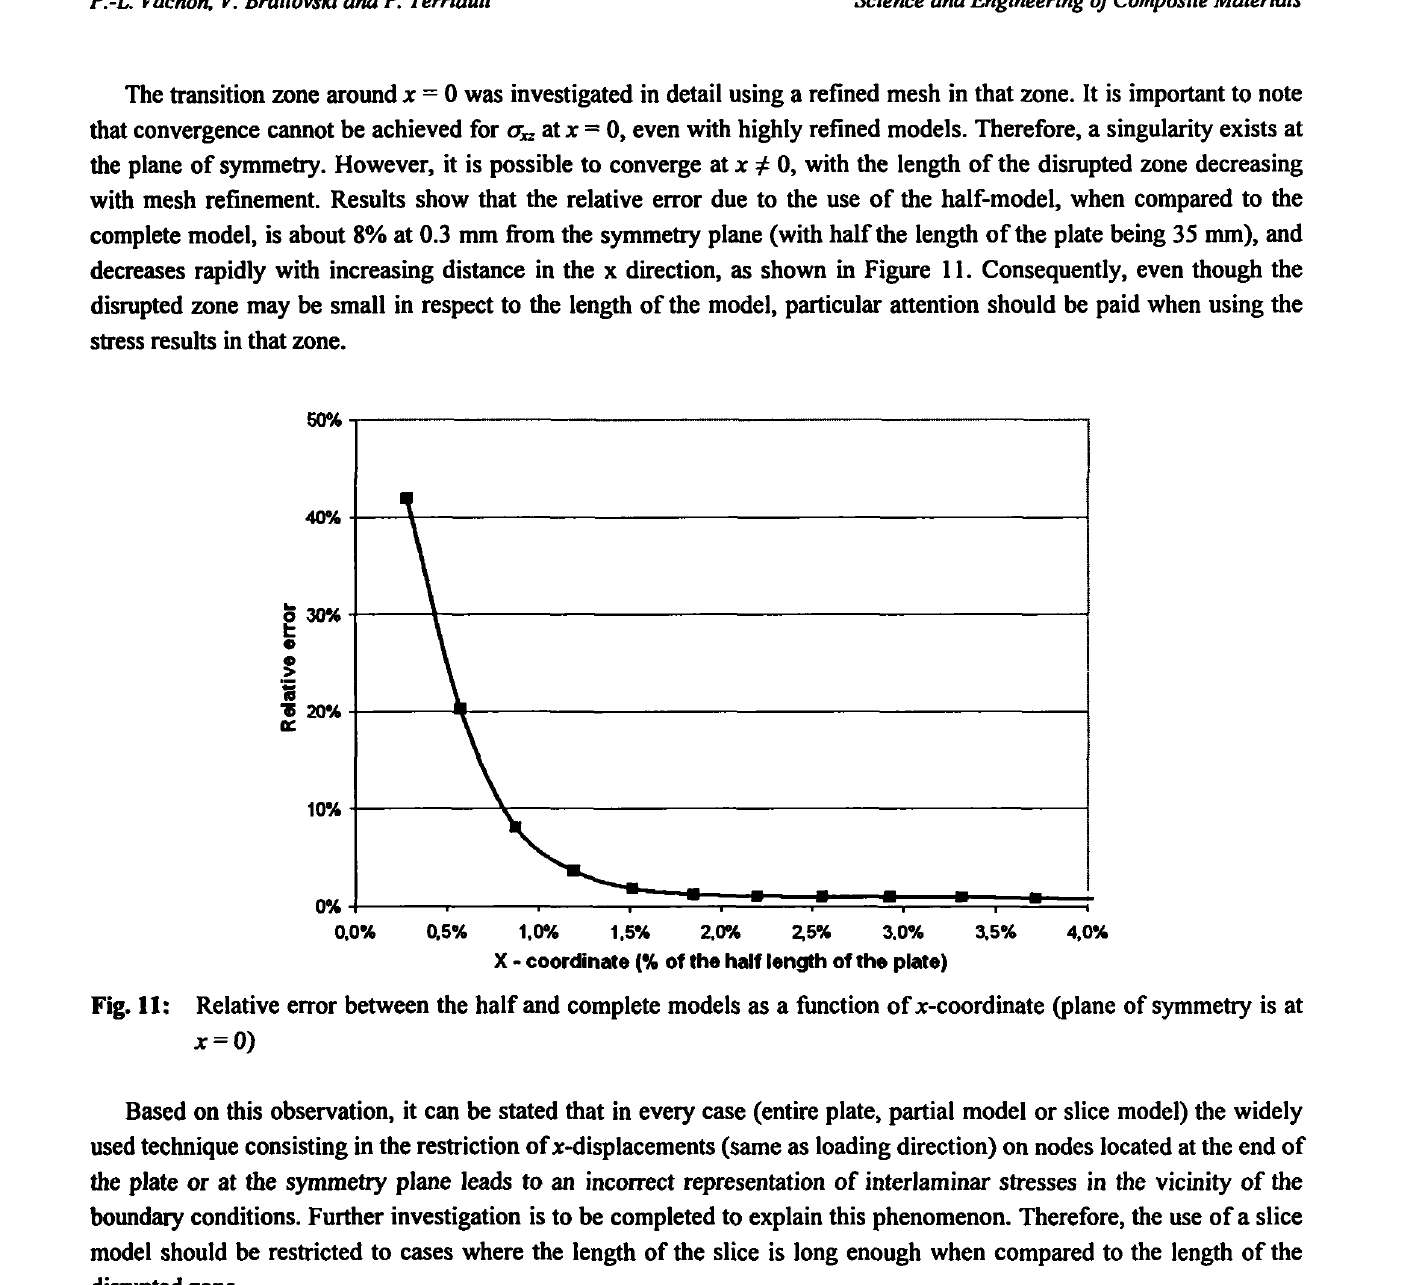
Based on this observation, it can be stated that in every case (entire plate, partial model or slice model) the widely used technique consisting in the restriction of x-displacements (same as loading direction) on nodes located at the end of the plate or at the symmetry plane leads to an incorrect representation of interlaminar stresses in the vicinity of the boundary conditions. Further investigation is to be completed to explain this phenomenon. Therefore, the use of a slice model should be restricted to cases where the length of the slice is long enough when compared to the length of the disrupted